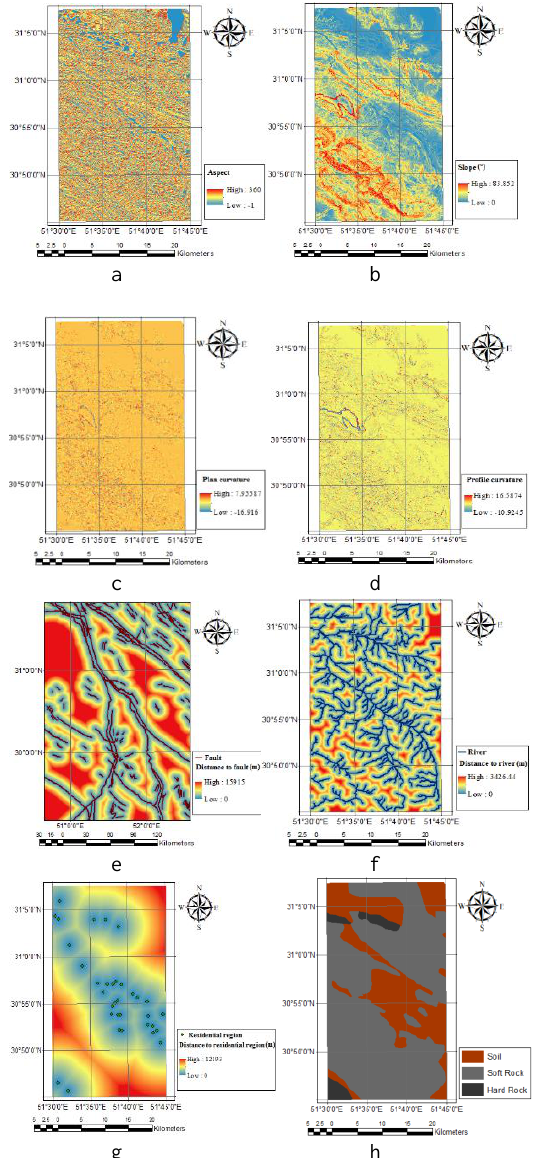
Figure 6. Effective information layers: a Precipitation, b Roads and distance and roads